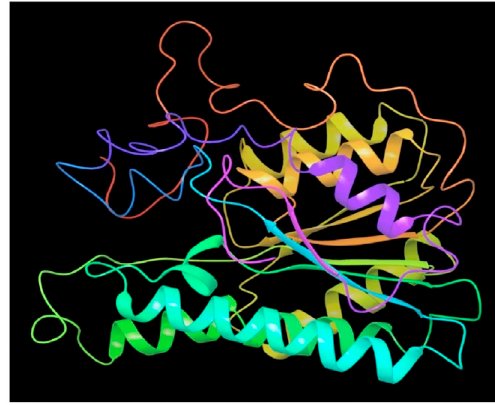
Fig. 2A. Modeled 3D structure of SDR protein (FOXG_00472) in Fusarium oxysporum f. sp .